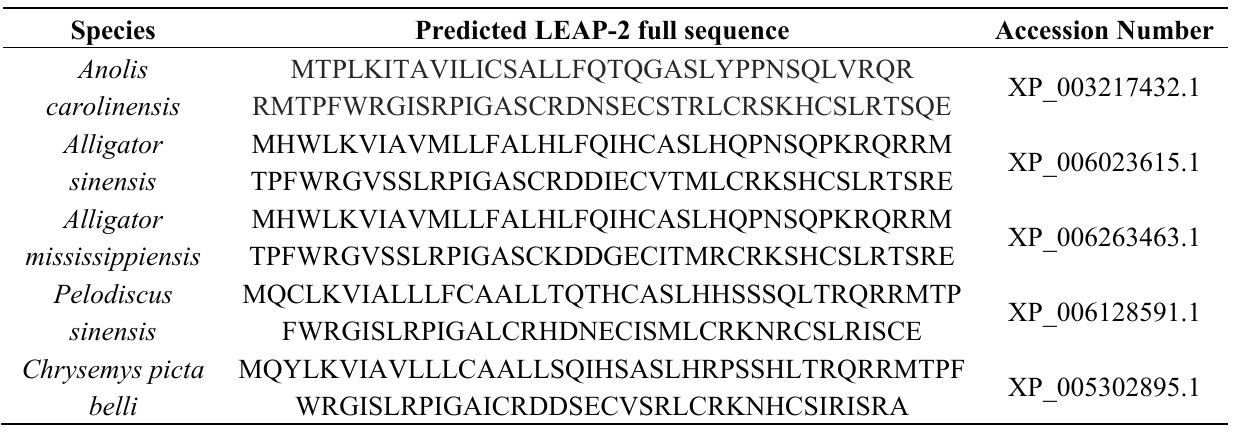
Table 7. Predicted LEAP-2 pre-propeptide amino-acid sequences identified in